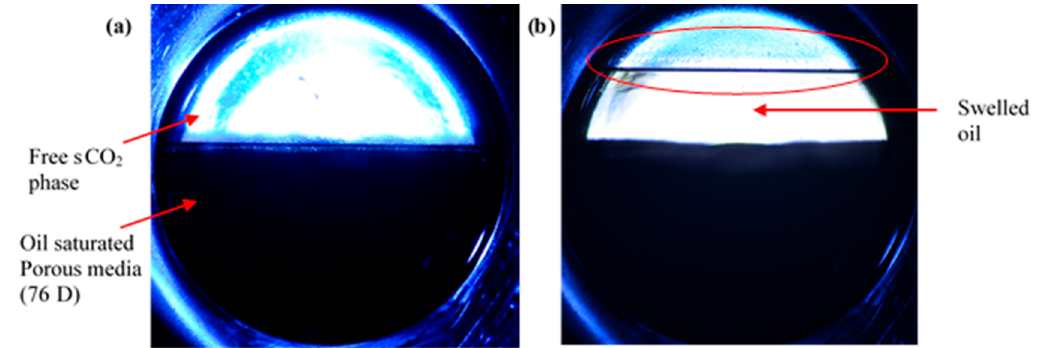
Figure 13. Illustration of oil swelling due to CO 2 mixing. Experiments were carried out by Amarasinghe et al. [25] inside a 2-dimensional (2-dim) Hele-Shaw cell using 76 D oil ( n -decane)-saturated porous media at 100 bar and 50 °C. ( a ) Beginning of the experiment with oil-saturated porous media and free CO 2 phase. ( b ) At the end of experiment, after 170 min, with swelled oil phase (46% of original oil in place (OOIP)). Red circle shows the moved CO 2 –oil interface.